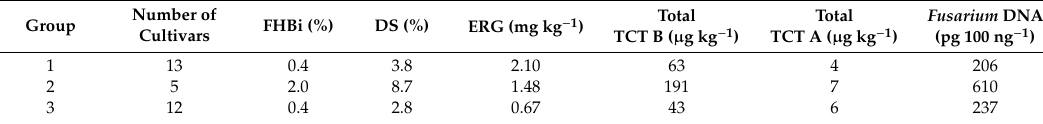
Table 9. Average values for groups shown in Figure